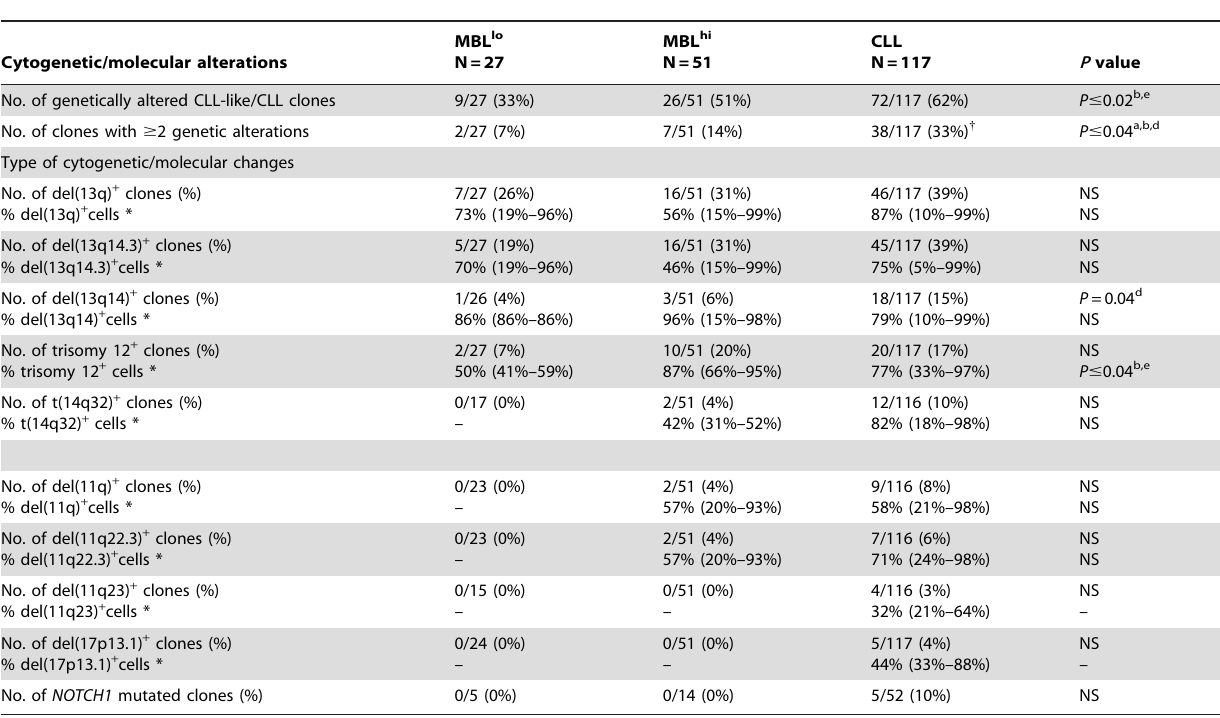
Table 3. Cytogenetic and molecular features of MBL lo , MBL hi and CLL B-cell